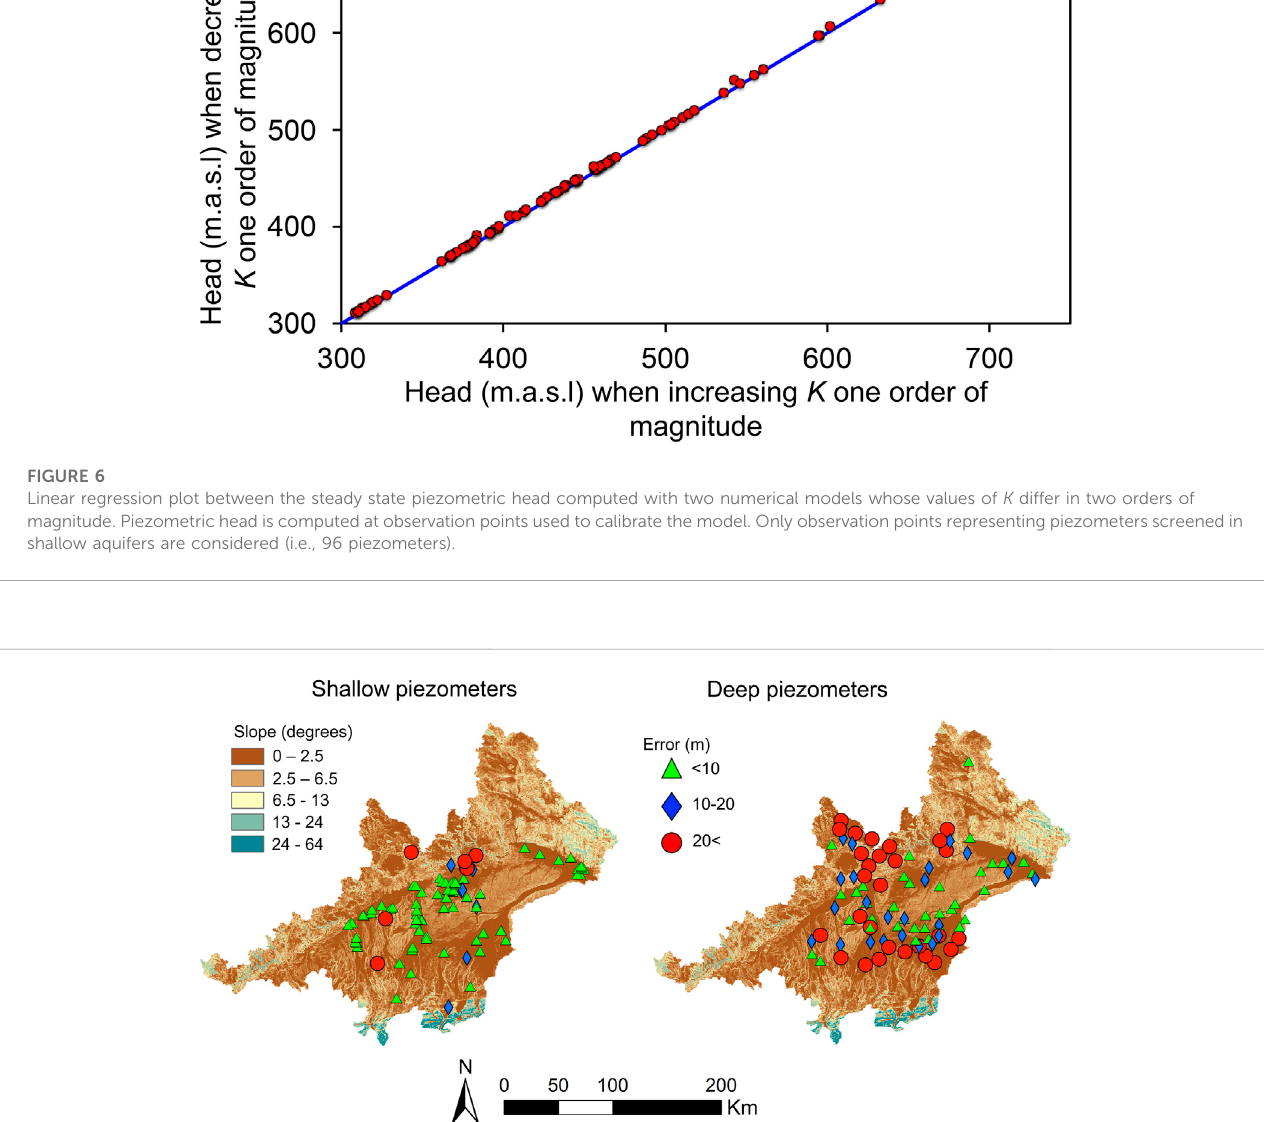
Frontiers in Earth